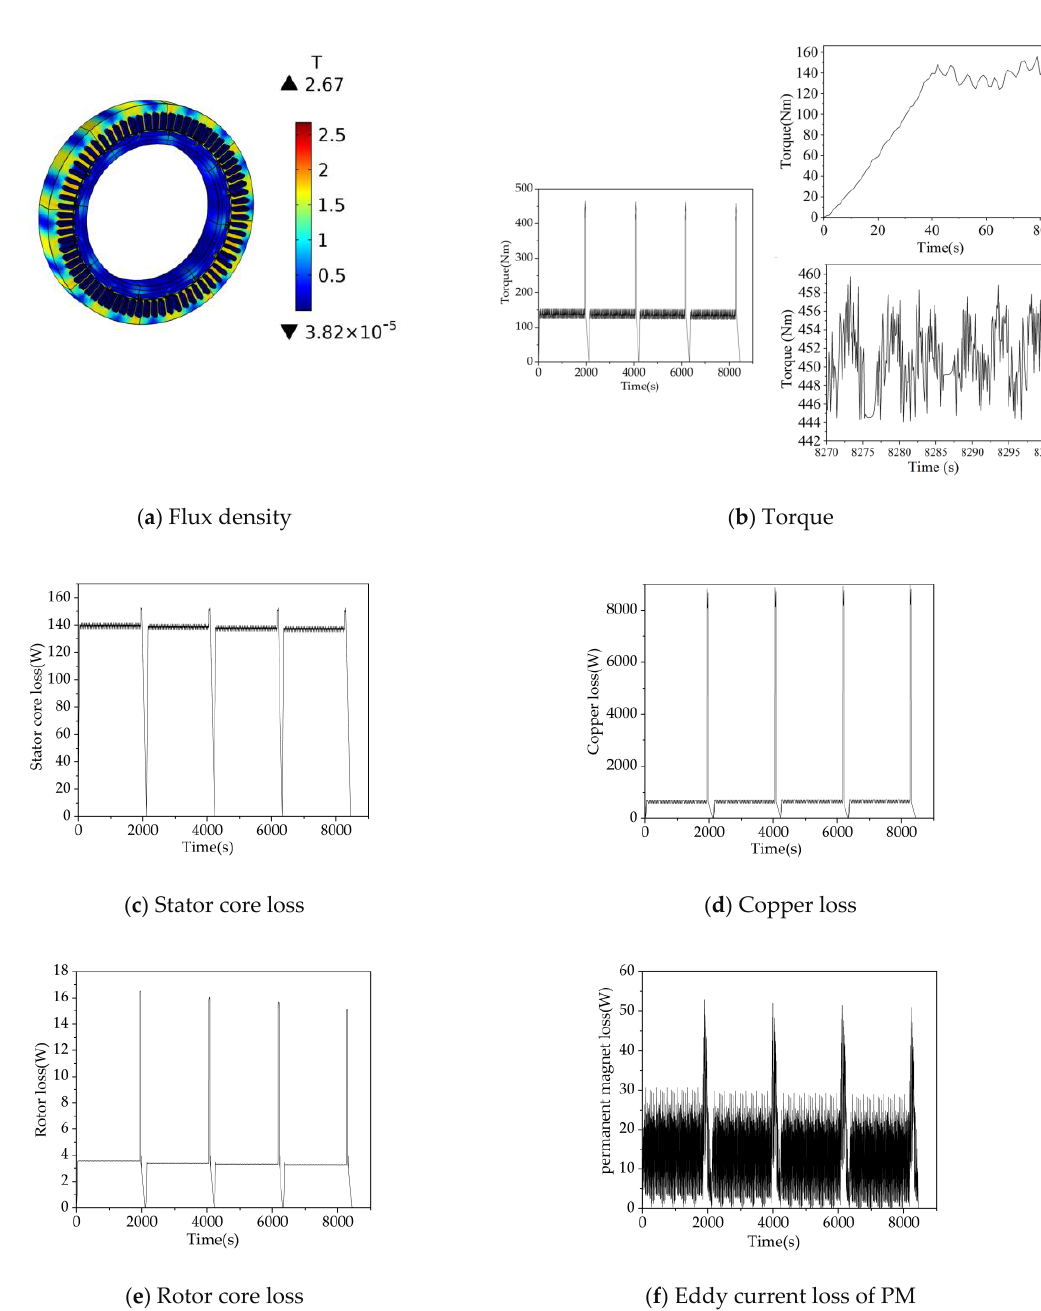
Figure 16. Time-varying curve of electromagnetic torque and the loss of motor.